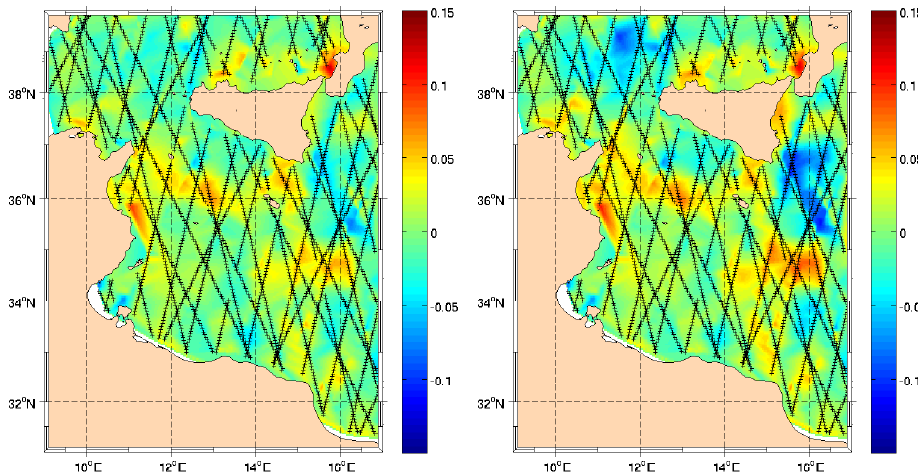
Fig. 3. Misfits for AN background (left) and SIM (right). The maps are obtained through linear interpolation of the misfits between model and Along Track SLA V1 data, whose position is also shown. SLA assimilation; the AN field shows this structure lowered in latitude and forming a coherent anticyclone. The same can be observed in the satellite SST image that clearly shows the anticyclone approximately at the same location and with a similar shape and